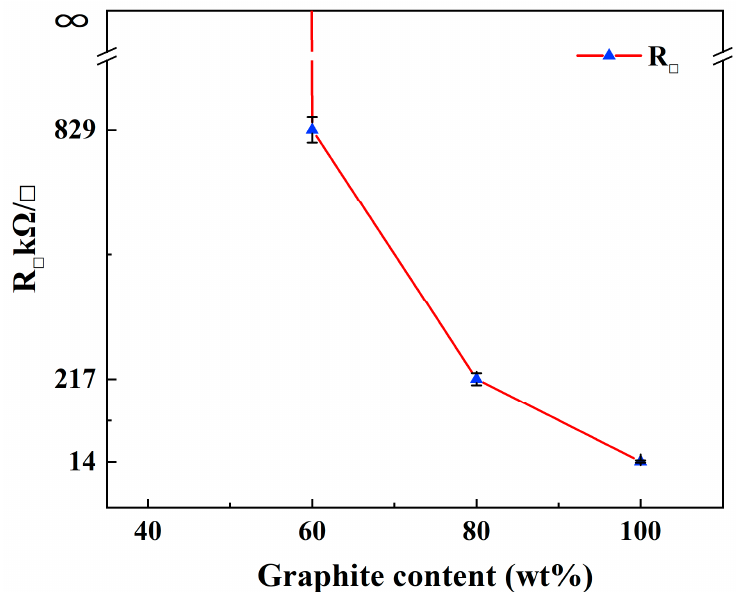
Figure 8. Variations in coating square resistance with changes in graphite content.